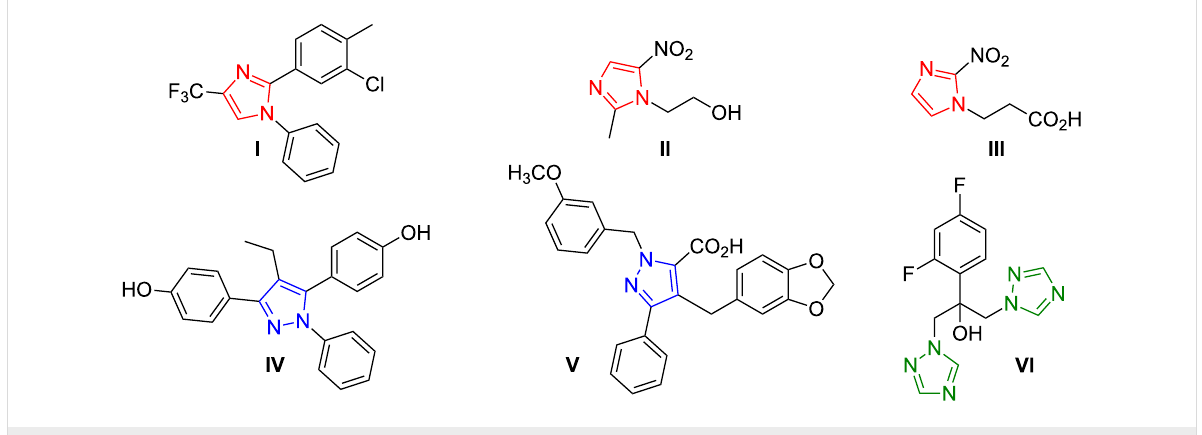
Figure 1: Examples of azole derivatives as important therapeutic agents.